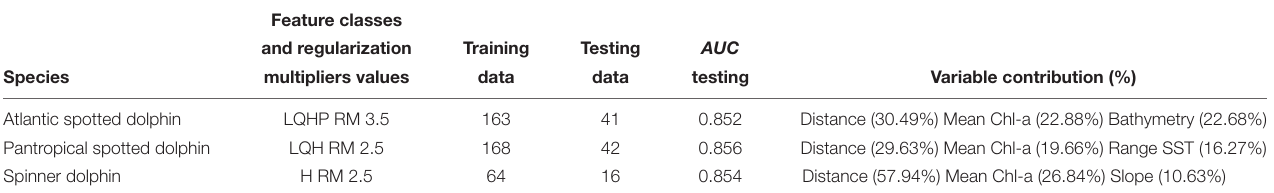
TABLE 2 | The ecological niche models with the best configuration for each species, the number of training and testing data, the AUC testing values and the relative contributions of the major environmental variables to the Maxent models with dynamic and static